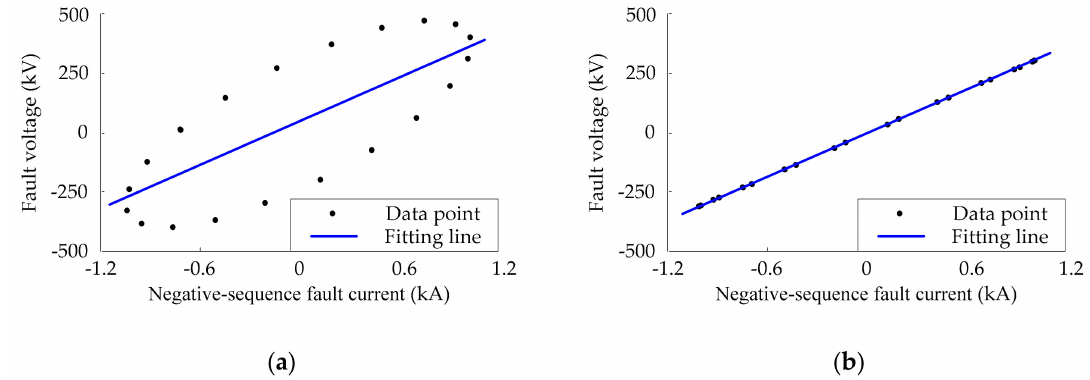
Figure 9. Fitting results of the fault voltage and negative-sequence fault current under the phase-A-to-ground fault: ( a ) Starting point of the line; ( b ) Fault point of the line.